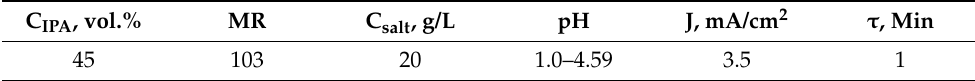
Table 2. The parameters of the reaction medium for determining the pH effect. C IPA , vol.%